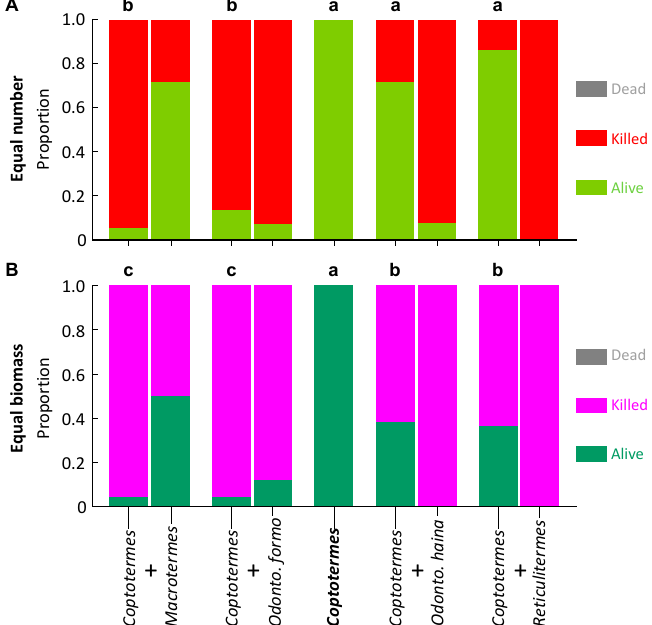
Figure 3. Survival of Coptotermes formosanus in laboratory aggression experiments. The control appears as a single column as it contains one species, whereas paired species treatments are paired columns, the C. formosanus on the left of each pair. Columns surmounted by different letters signify significantly different proportion survival (Bonferroni corrected pairwise comparisons) for C. formosanus . ( A ) Equal number of termites; ( B ) Equal biomass of termites.